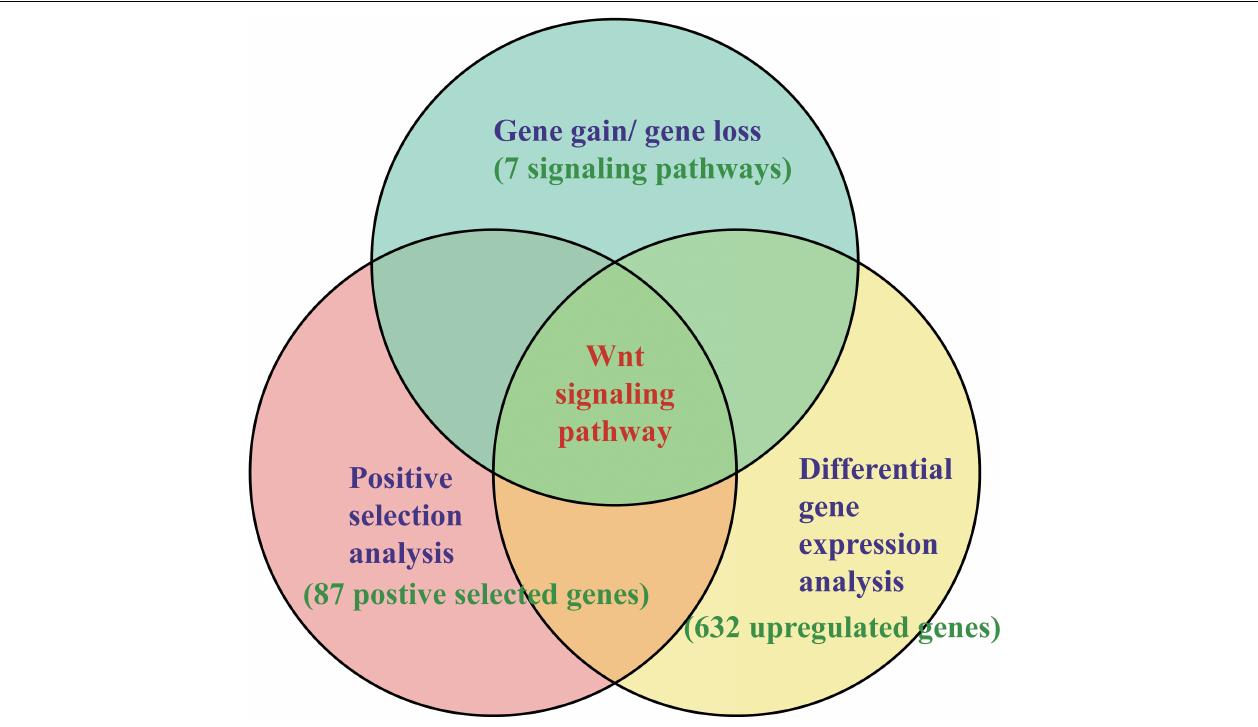
FIGURE 1 | Methods of identifying key pathways and genes in regeneration. The methods combined the results of gene gain/gene loss analysis, positive selection analysis, and DGE analysis.